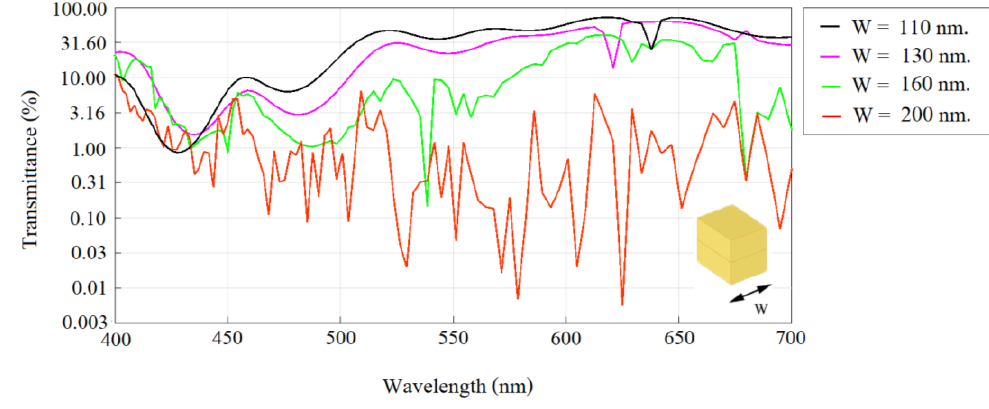
Figure 4. Transmittance when H is varied from 10 to 130 nm.